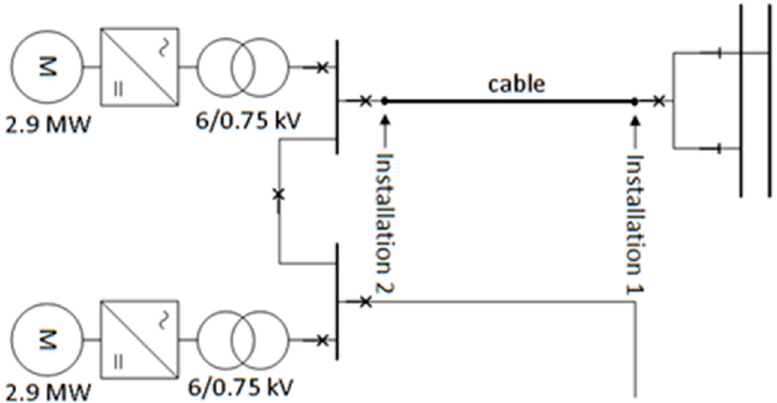
Figure 1. Analyzed section of the 6 kV cable network with connected broadband over power line (BPL) devices.